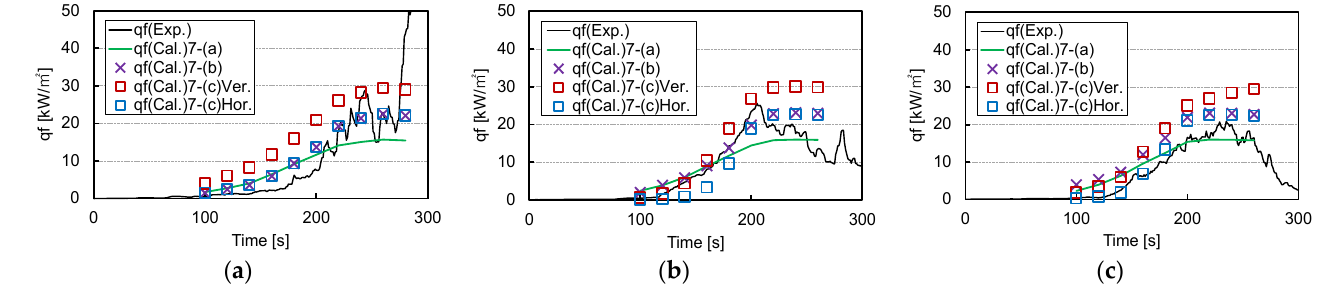
Figure 8. Comparison of calculated values obtained using the methods illustrated in Figure 7a,b as the configuration factor with experimental values: ( a ) HB=0 mm; ( b ) HB=215 mm; ( c ) HB=515 mm.